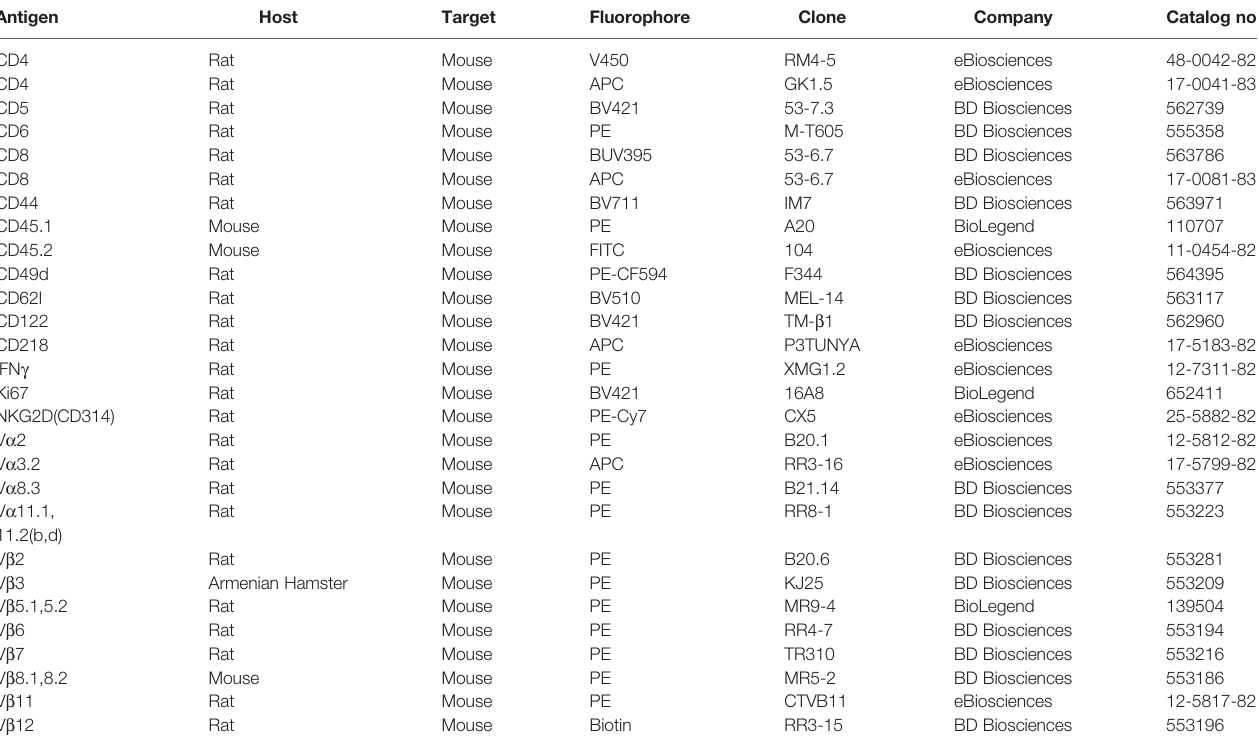
TABLE 1 | Antibodies used for fl ow cytometry.